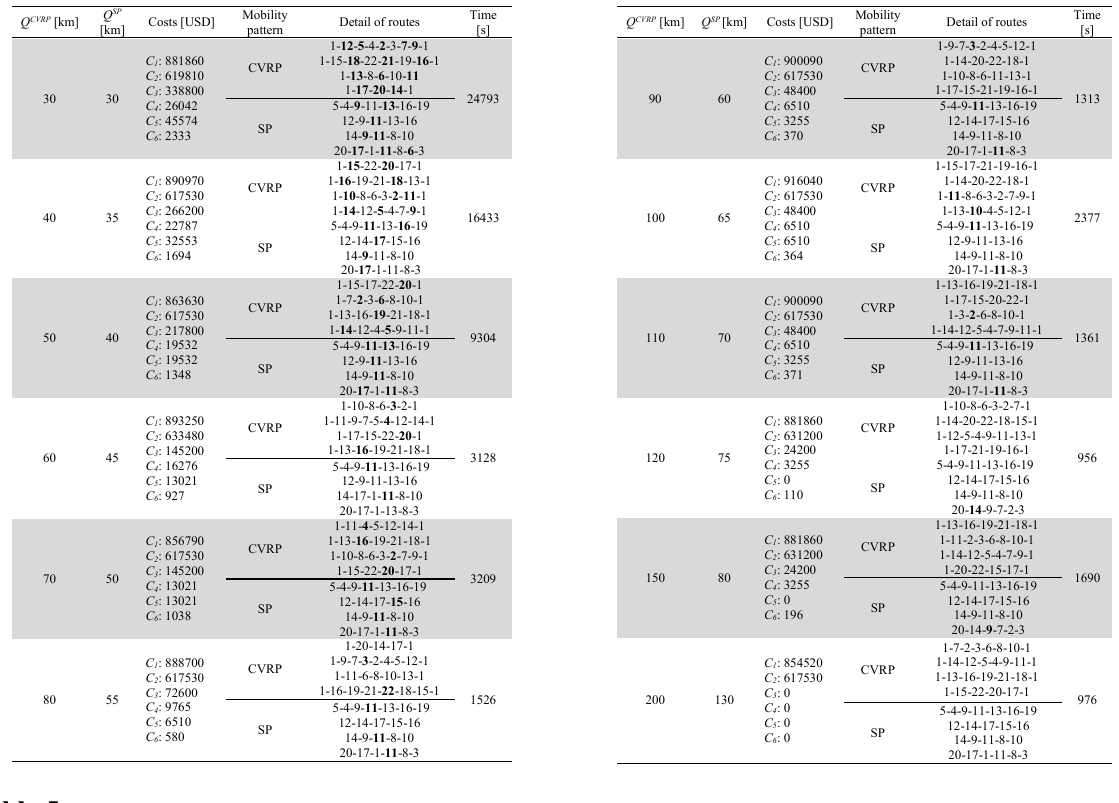
Results for En22k4-IEEE123 with linearized mathematical model Q CVRP [km] Q SP